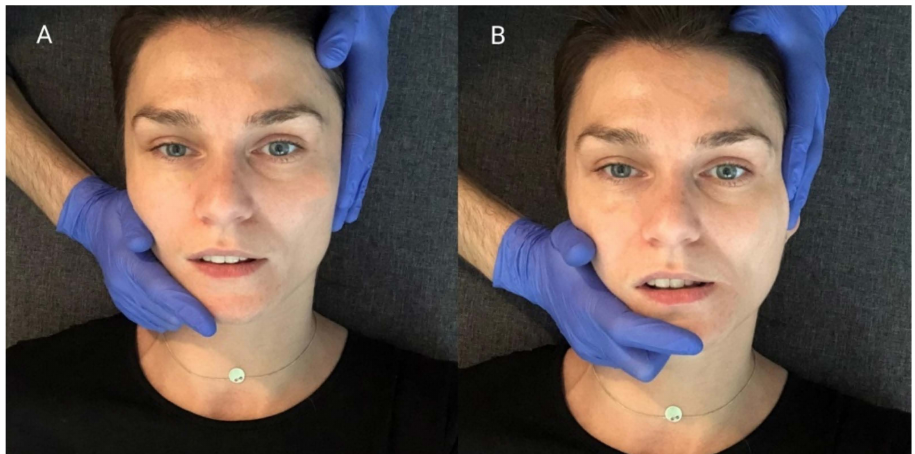
Figure 4. PIR treatment of the muscles responsible for the lateral movement of the mandible towards the right: ( A ) Starting position; ( B ) passive lateral movement of the mandible.